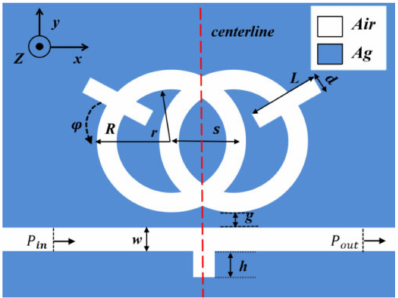
Figure 1. 2D structural